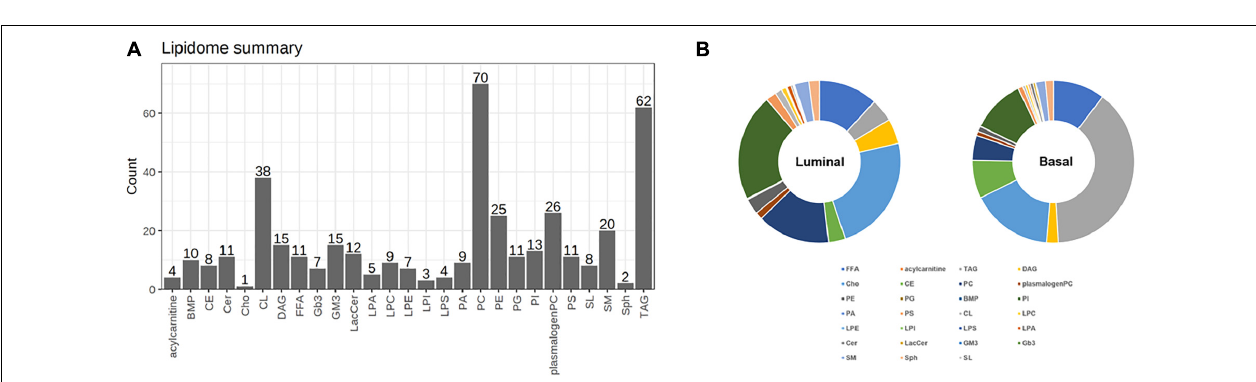
FIGURE 1 | Transcriptome analysis reveals changes in lipid and metabolic pathways. (A) Expression heatmap of specific MIBC basal and luminal markers. (B) GSEA analysis showed the activation pathways in basal and luminal MIBC subtypes.